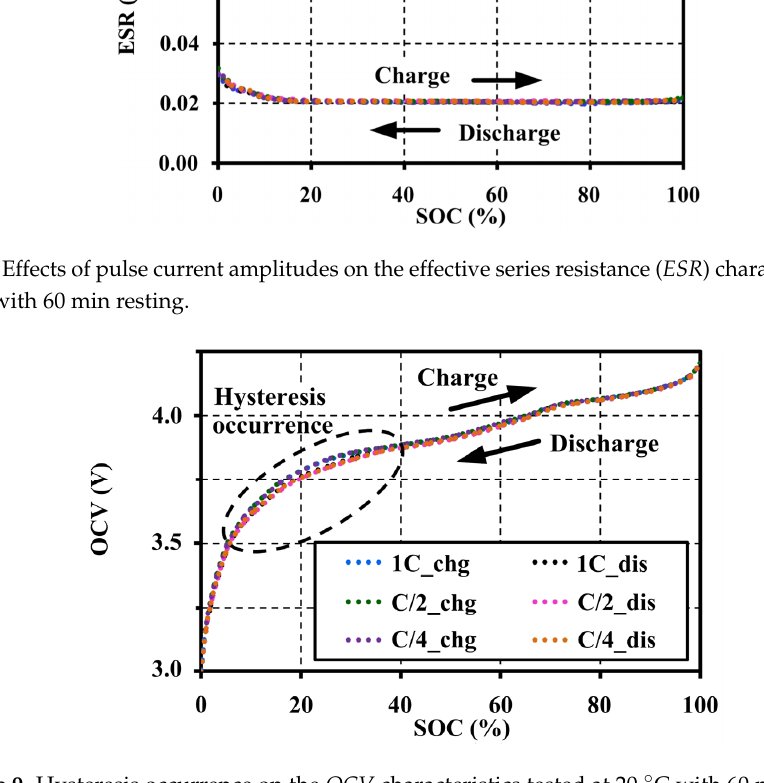
Figure 8. Effects of pulse current amplitudes on the effective series resistance ( ESR ) characteristic tested at 20 °C with 60 min resting.